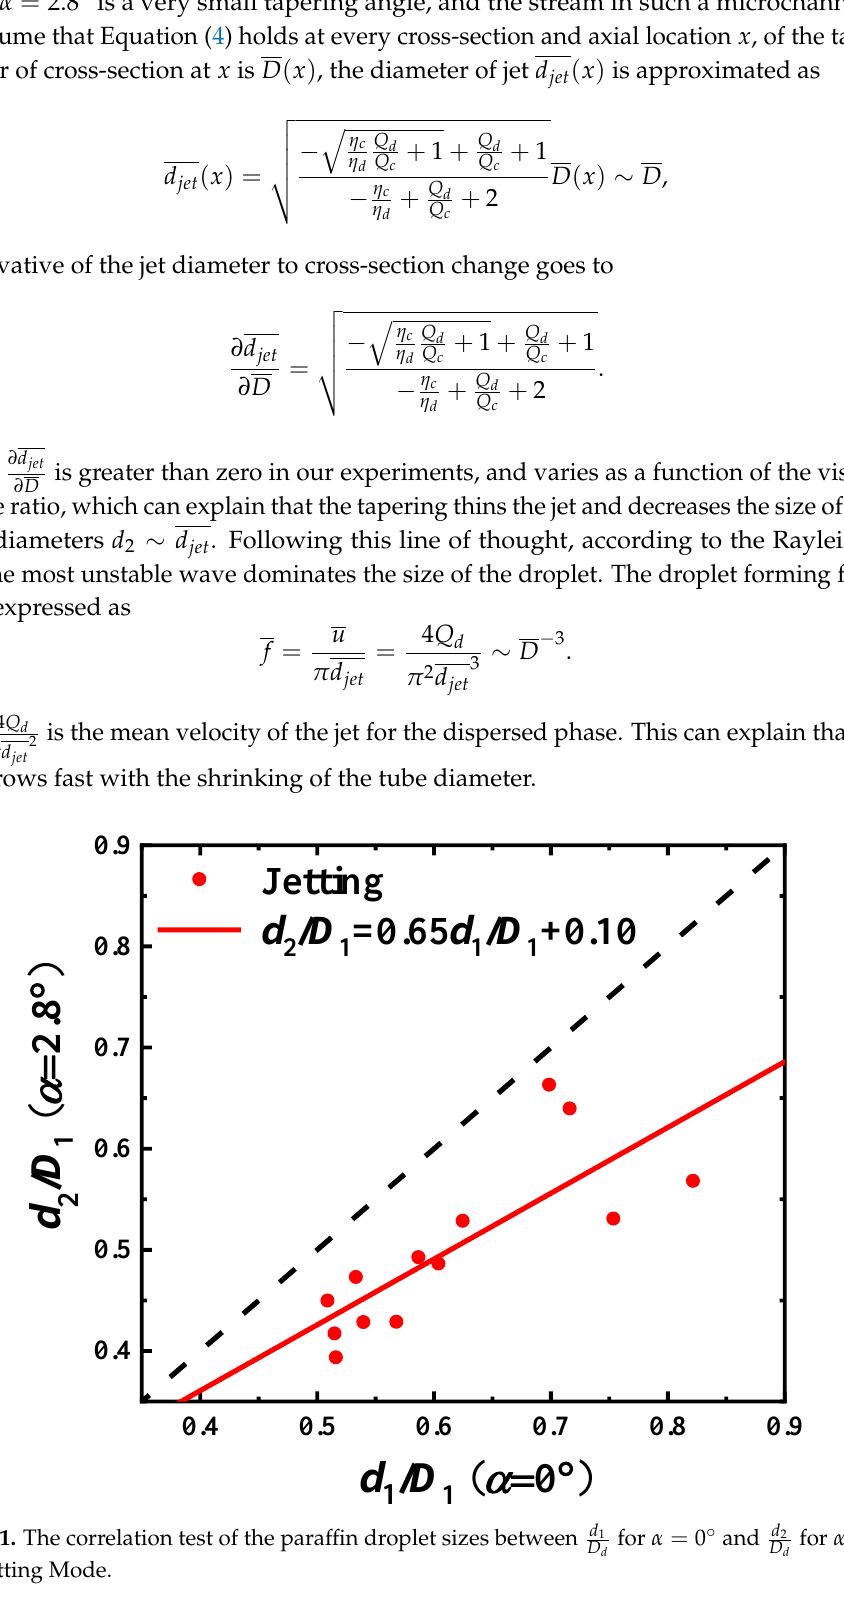
for α = 0 ◦ and d 2 for α = 2.8 ◦ D d D d